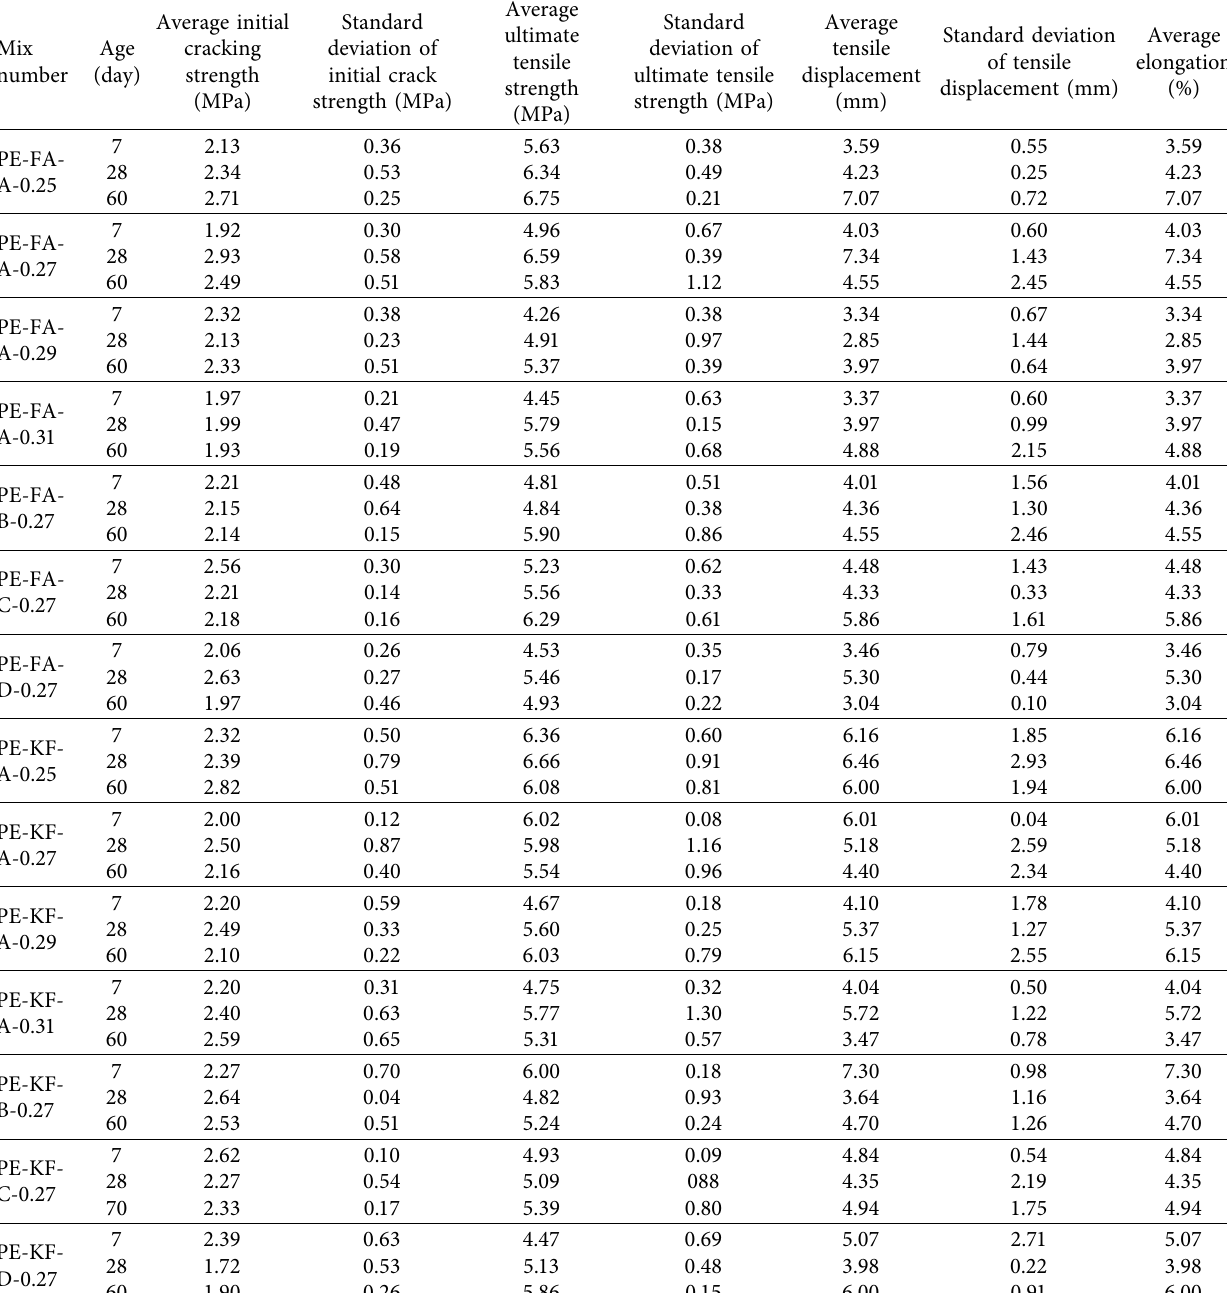
Table 8: Uniaxial tensile test results of the